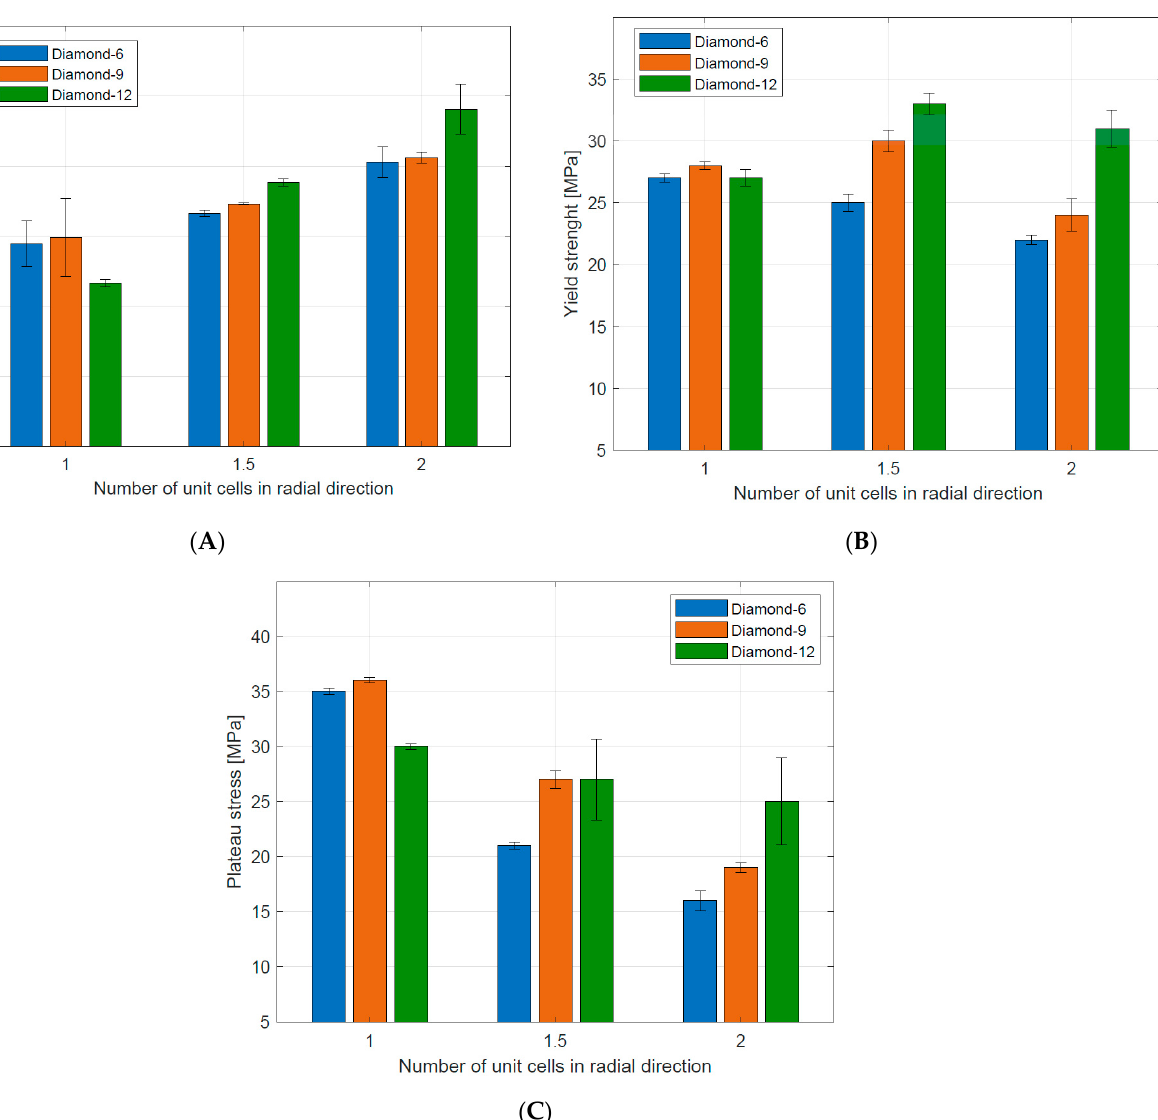
Figure 11. Mechanical properties of tested Diamond TPMS cylindrical structures: ( A ) elastic modulus; ( B ) yield strength; ( C ) plateau stress.